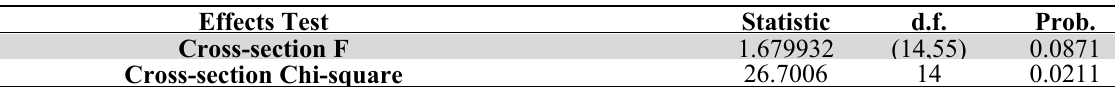
Fixed effect Hausman